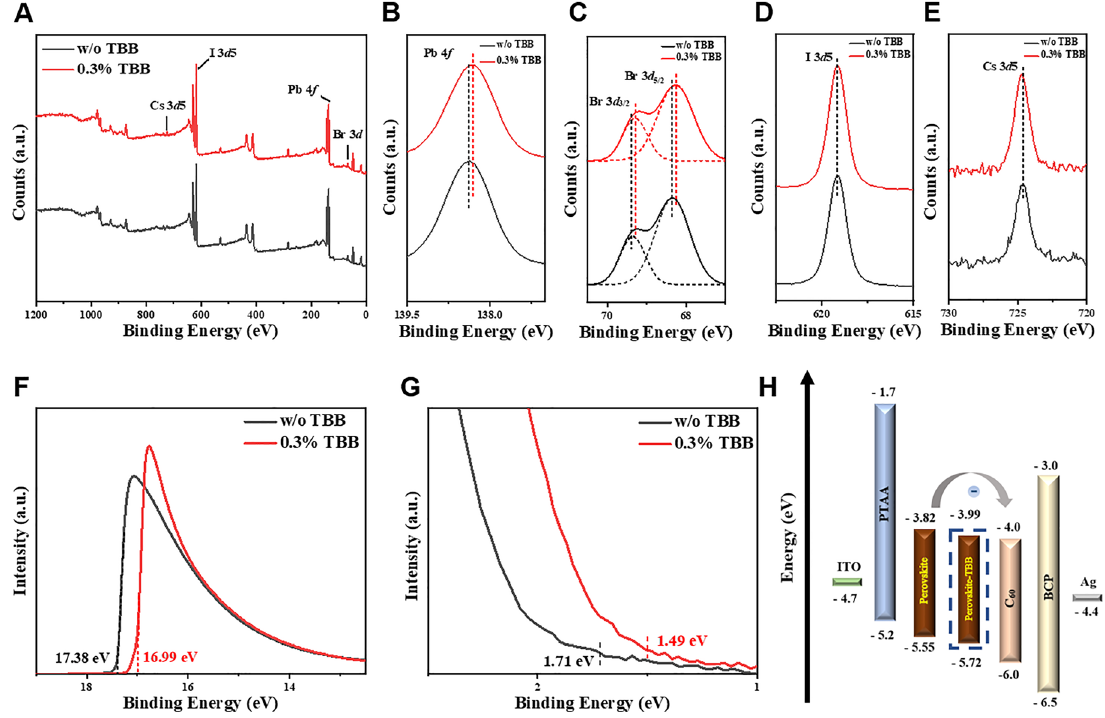
Figure4: X-rayphotoelectronspectra(XPS)andultravioletphotoemissionspectroscopy(UPS)characterizationsofperovskitesamplesdoped without 1,3,5-tris (bromomethyl) benzene (TBB) and with 0.3% TBB. (A)Elementalsurveyspectraofthesetwosamples.(B – E)High-resolutionresultsofPb4f,Br3d,I3d5andCs3d5.(F)Secondaryelectroncut-off edge. (G) Valence band. (H) Energy level diagram of the entire